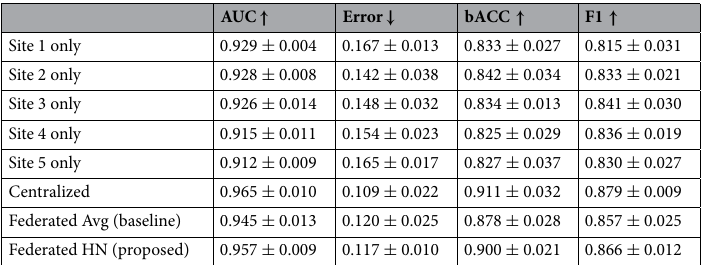
Table 3. Results of classification on PANDA with or without Federated Learning.